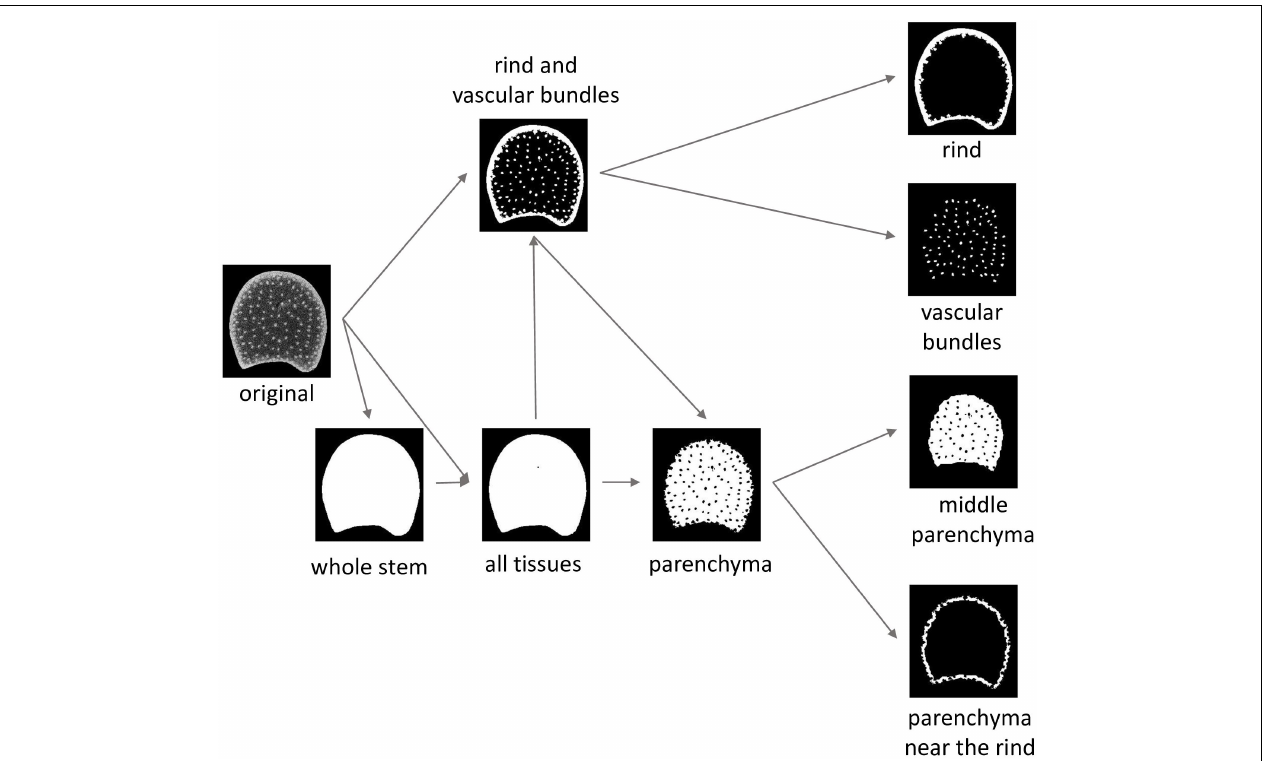
FIGURE 3 | Image segmentation workflow and resulting tissue regions of interests (ROIs). The “whole stem” ROI corresponds to the mask of the section. In the “all tissues” ROI, the holes encountered in some of the sections are segmented. Parenchyma ROI and rind and vascular bundle ROI are temporary ROIs necessary to compute tissue ROIs. Middle parenchyma ROI and rind parenchyma ROI are subregions of the parenchyma